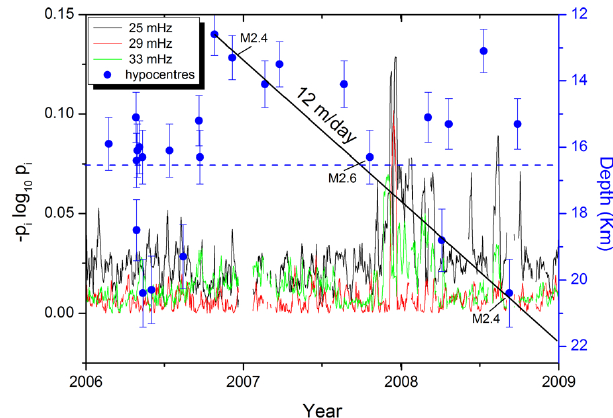
Fig. 5. Temporal behaviour of individual contributions with 25– 33mHz frequencies to total entropy (values indicated on the left y-axis) and deeper ( h > 12km) earthquakes (depths indicated on the right y-axis) in the L’Aquila seismic sequence in the three-year interval 6 April 2006–5 April 2009, in a radius of 20km from the main shock epicentre and with magnitude M ≥ 1.5. The horizontal dashed line represents a hypothetical depth where the brittle-ductile discontinuity might occur. The oblique solid line approximates the deepest earthquakes from the end of 2006 to the main shock occur- rence. We can notice a slow downward hypocentre migration with apparent velocity of 12mday − 1 . The figure also shows the mag- nitude of the largest deep earthquakes with M ≥ 2.4 (all the others shown in this figure have smaller magnitudes): they all lie close to the solid oblique